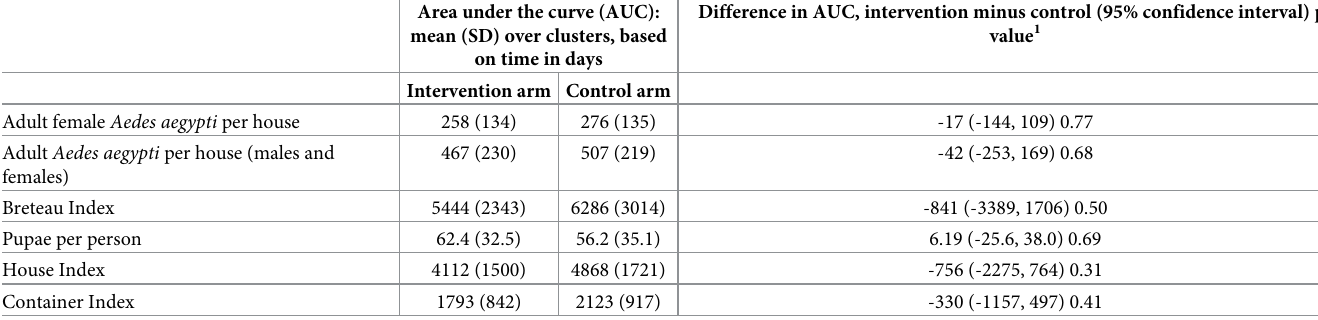
Table 3. Summary of AUC analyses of entomological endpoints between intervention and control